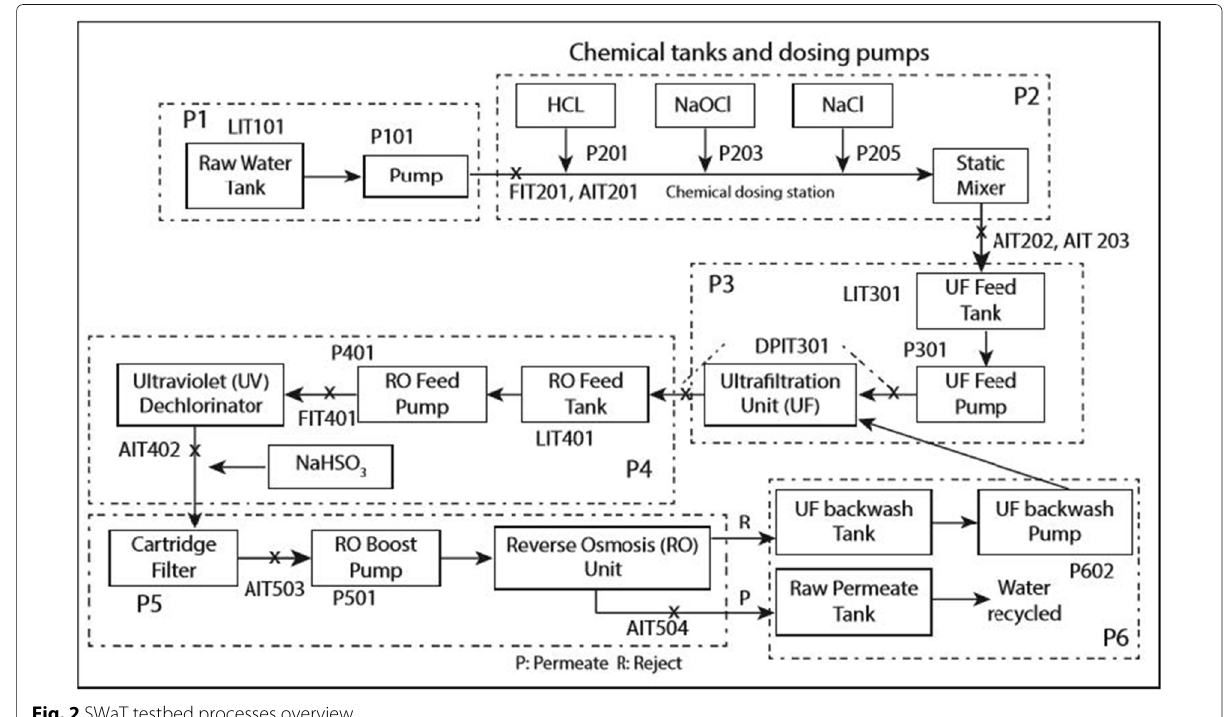
Fig. 2 SWaT testbed processes